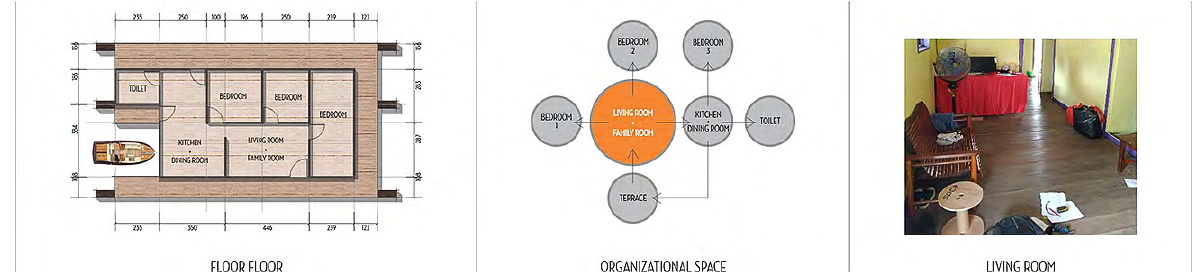
Figure 13. (a) Floor plan case 5; (b) Organizational space case 5; (c) Living room case